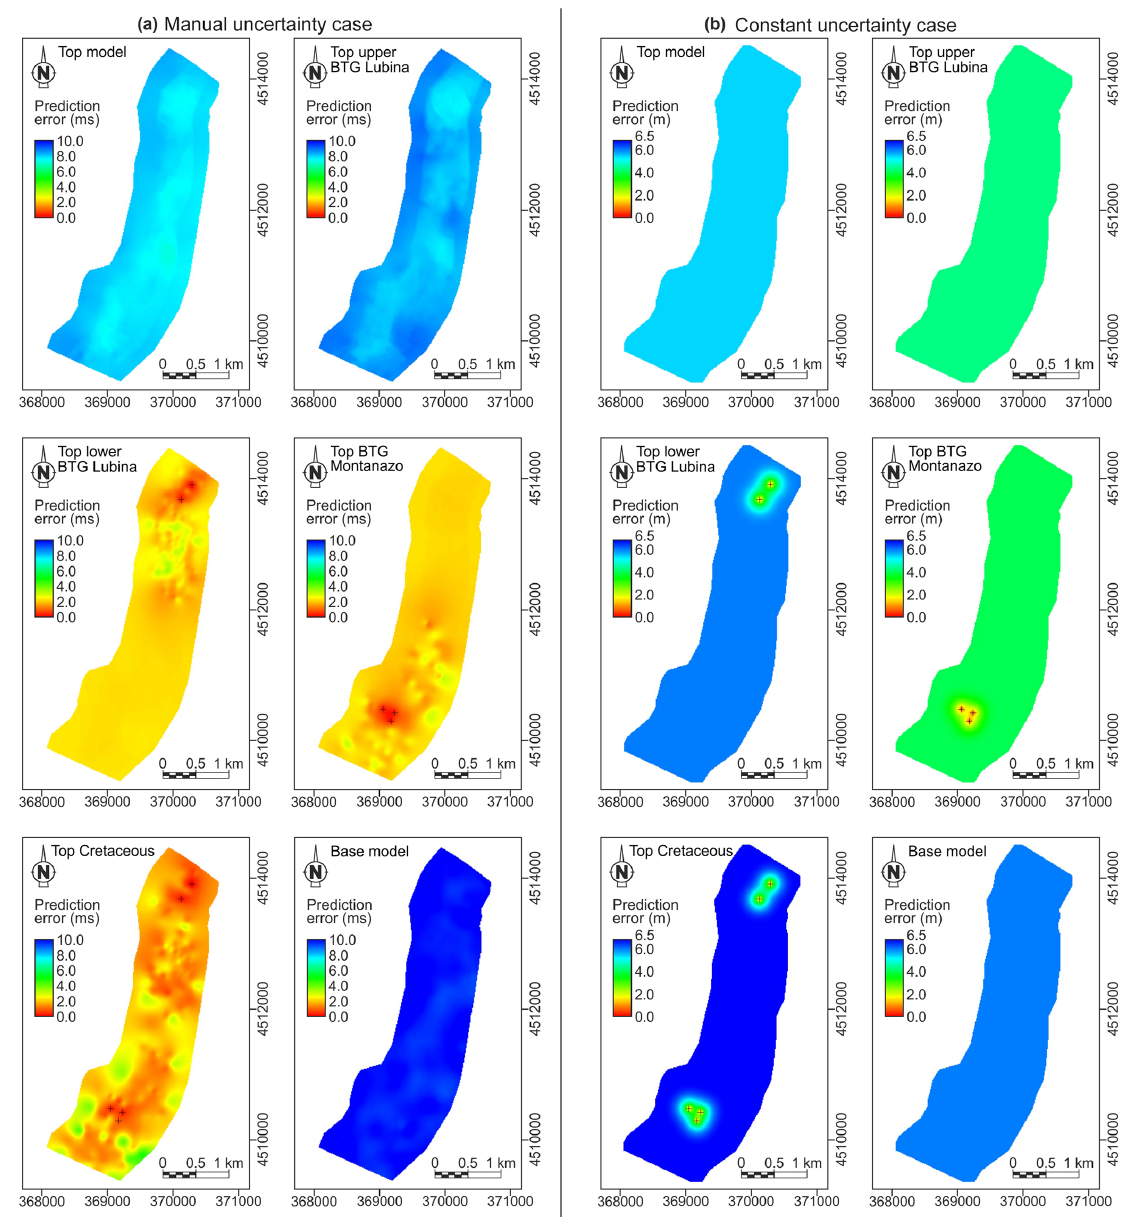
Figure 8. Horizon uncertainty maps obtained from the prediction method, describing the prediction error for all the horizons in (a) the manual and (b) the constant uncertainty cases. The top of the lower BTG in Lubina, the top of the BTG in Montanazo and the top of the Cretaceous have well picks available (indicated by crosses). For these horizons, the predicted errors are lower than for those without well picks (i.e., top model, top upper BTG Lubina and base